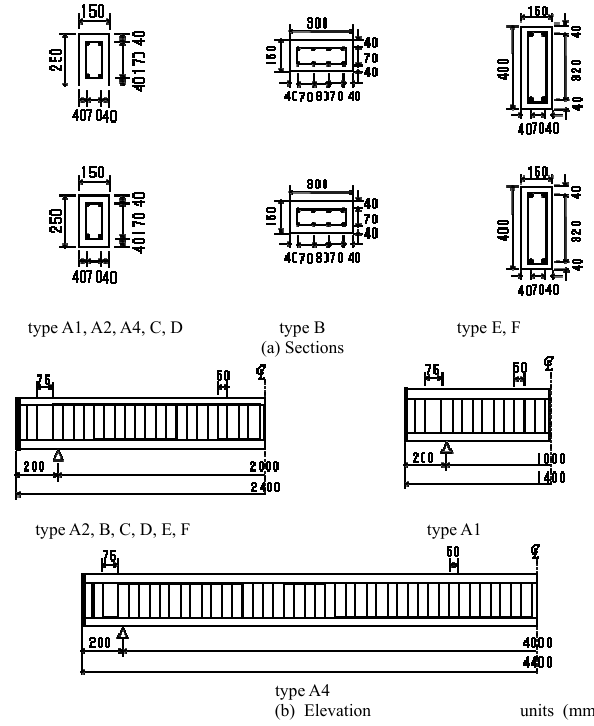
Figure 2. Details of reinforced concrete beams Fig. 2. Details of reinforced concrete